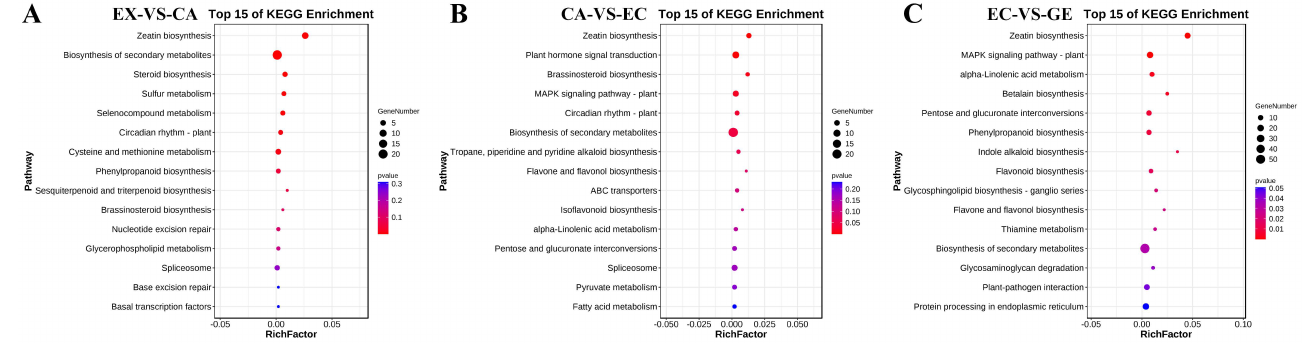
Figure 5. KEGG analysis of potential DE mRNA target genes of lncRNA. ( A – C ) represent the KEGG enrichment pathway maps of DE mRNA target genes of DE lncRNA in EX-VS-CA, CA-VS-EC, and EC-VS-GE stages,